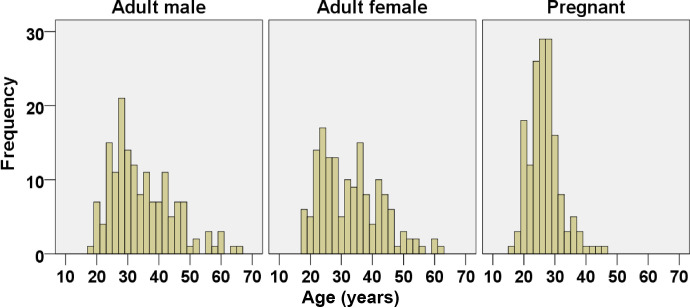
Age distribution histogram of study participants.